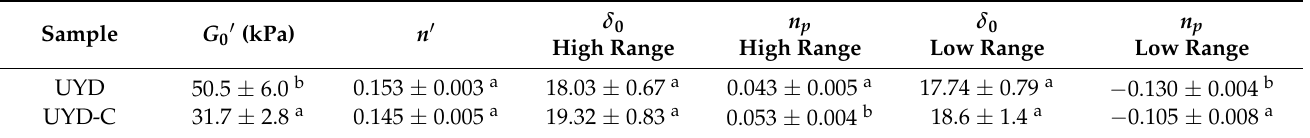
Table 2. Elastic parameter at 1 rad/s ( G 0 (cid:48) ), n (cid:48) exponent (Equation (3)) and phase angle ( δ ) (Equation (4)) at high and low frequency intervals of unyeasted wheat dough (UYD) and CH-rich unyeasted wheat dough